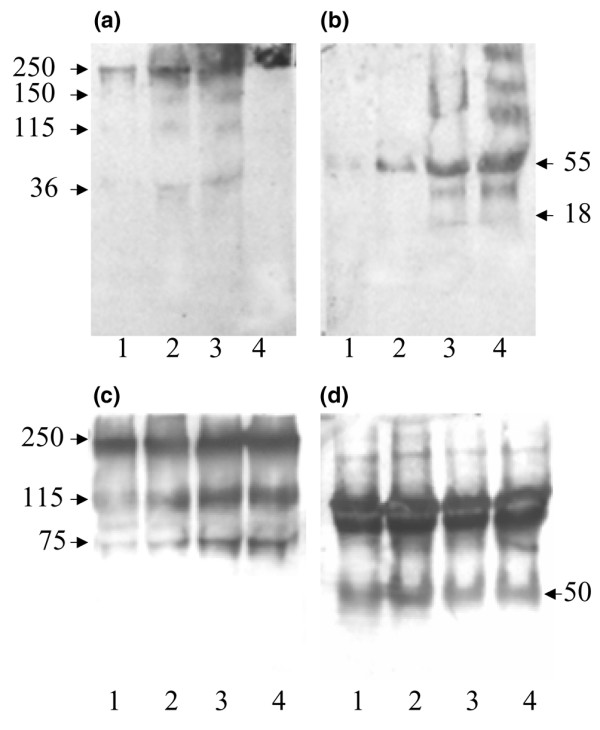
Western blots of synovial fluid samples. Representative western blots of a synovial fluid sample obtained (a), (b) from a grade 0 normal asymptomatic organ donor or (c), (d) from a patient with rheumatoid arthritis using an anti-mature osteogenic protein 1 (OP-1) antibody (MAB354) demonstrating the pro-form and mature form of OP-1 protein. (a) and (c) Nonreduced conditions, (b) and (d) reduced with β-mercaptoethanol. (a) and (b) Sample was loaded at different dilutions of sample buffer in the amount of 30 μl/lane: lane 1, 1:1000; lane 2, 1:100; lane 3, 1:10; and lane 4, 1:5. (c) and (d) Undiluted sample was digested with the following enzymes and then loaded onto each lane at 30 μg protein: lane 1, control, no treatment; lane 2, hyaluronidase (50 units/ml); lane 3, chondroitinase ABC (0.1 U/ml); lane 4, combination of hyaluronidase (50 units/ml) and chondroitinase ABC (0.1 U/ml). The numbers on gels represent the size of the protein bands of interest.